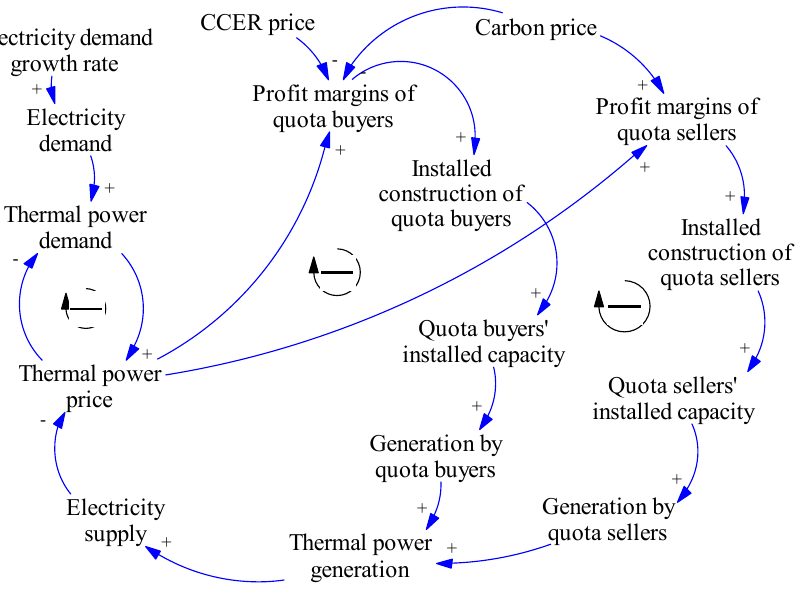
Figure 5. Causal cycle diagram of power market.